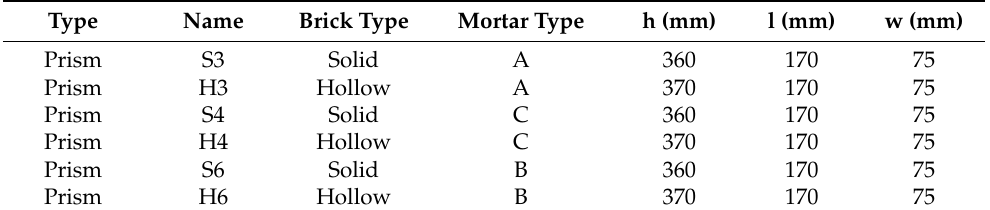
Table 2. Test matrix and dimensions of the specimens.